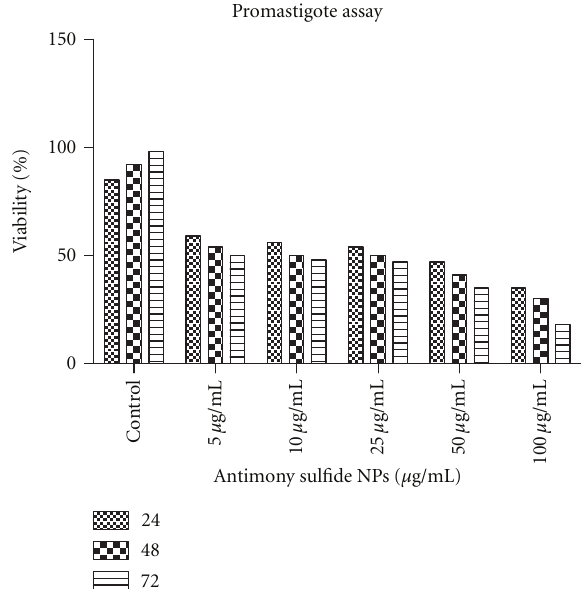
Figure 3: Viability of uninfected mouse macrophages in 5 dilutions of antimony sulfide NPs in vitro conditions during 24, 48, and 72 hours of incubation.